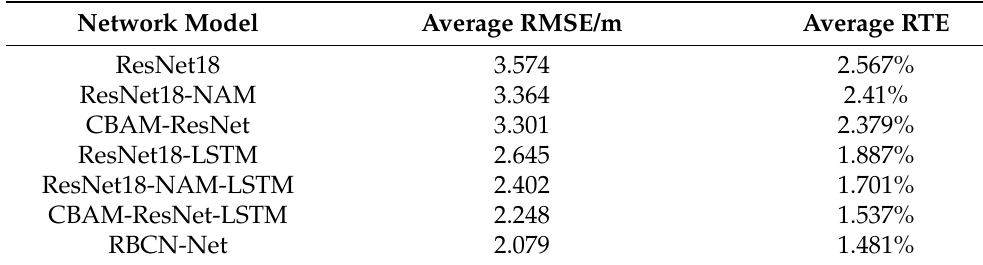
Table 5. Comparison of results of ablation